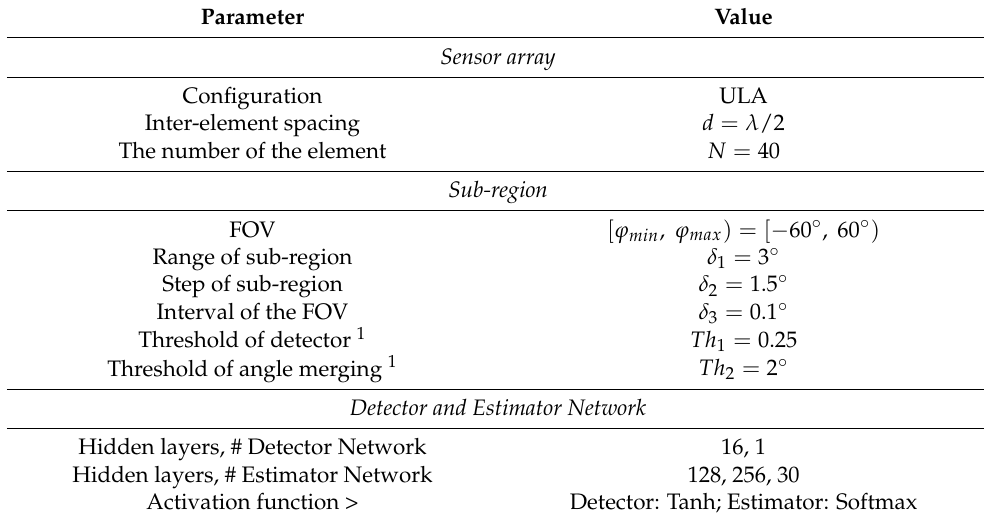
Table 1. Parameter